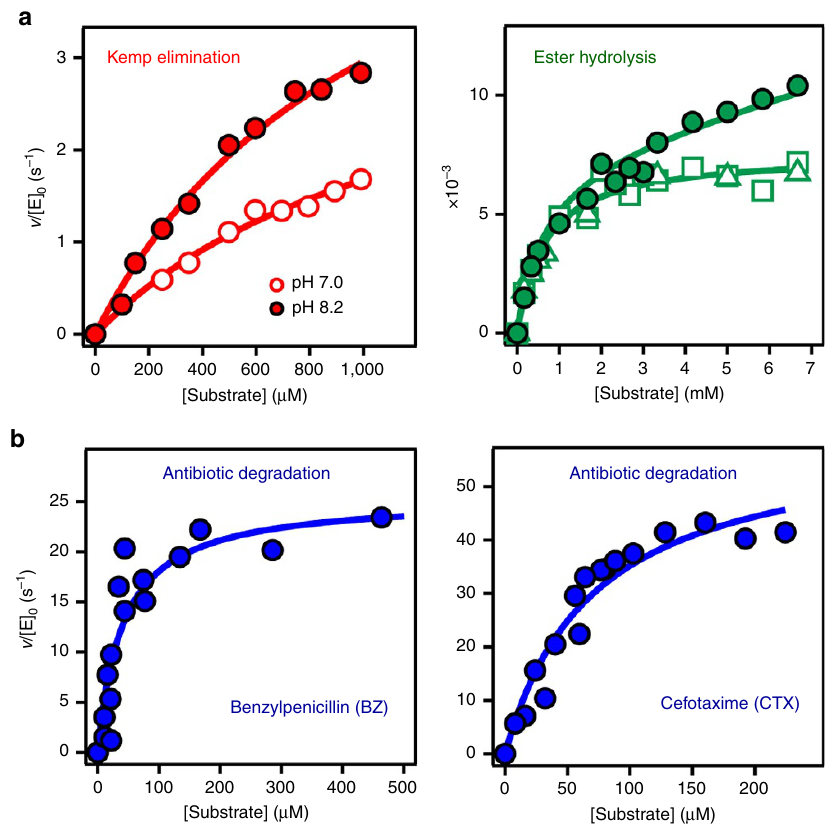
Figure 7 | Various activities of the W229D/F290W variant of the GNCA4 scaffold. ( a ) Activities linked to the new active site. ( b ) Activities linked to the natural preexisting active site. Plots of rate versus substrate concentration are shown in ( a , b ), with the continuous lines representing the best fits based on the Michaelis–Menten equation. Ester hydrolysis data correspond to p- nitrophenyl acetate hydrolysis and were obtained with the GNCA 4 -W229D/F290W variant (closed data points) and also with this variant modified to block any esterase activity at the natural, antibiotic degradation site. This was achieved by mutating the catalytic S70 to alanine (open squares) or by inactivation by clavulanic acid (open triangles). Catalytic parameters for ester hydrolysis discussed in the Main Text are derived from the Michaelis–Menten fit to the modified variants. The equation used to fit to the data of the unmodified variant includes an additional linear term to account for esterase activity at the antibiotic degradation site. The esterase catalytic efficiency at the natural active site is, however, found to be B 20-fold smaller than that at the new active